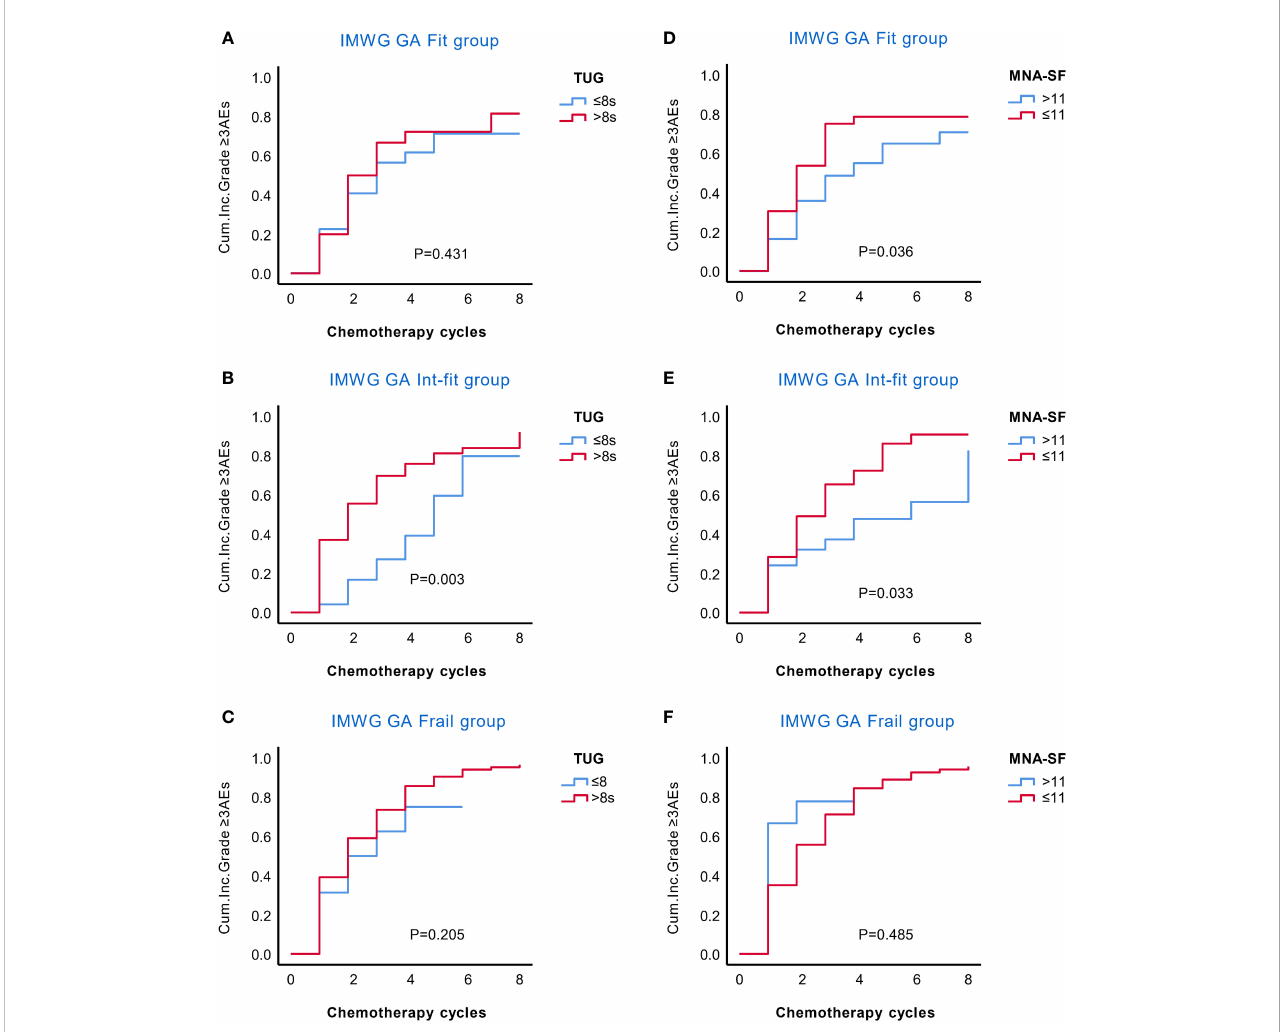
FIGURE 2 KM analysis of the occurrence of grade ≥ 3 AEs in the IMWG GA subgroups according to the TUG and MNA-SF scores. The rate of grade ≥ 3 AEs in the IMWG GA subgroups was strati fi ed by the TUG (A – C) and MNA-SF (D – F) scores. TUG only strati fi ed the risk of grade ≥ 3 AEs in the int- fi t subgroup (B) , but no signi fi cant association was found in the fi t and frail subgroups (A, C) . The MNA-SF strati fi ed the risk of grade ≥ 3 AEs both in the fi t and int- fi t subgroups (D, E) , but no signi fi cant association was found in the frail subgroup (F)